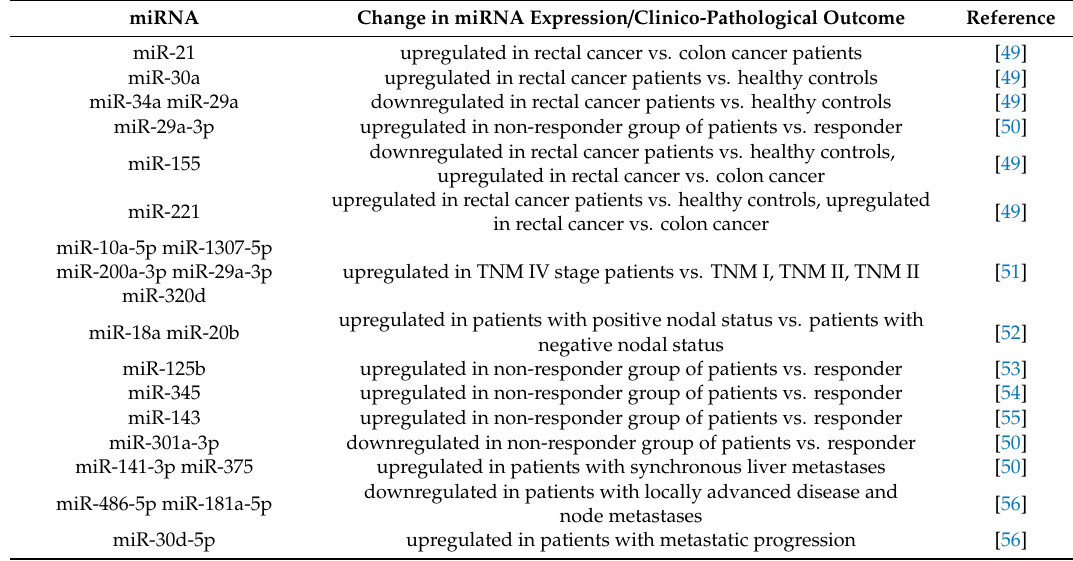
Table 1. Summary of circulating miRNAs associated with rectal